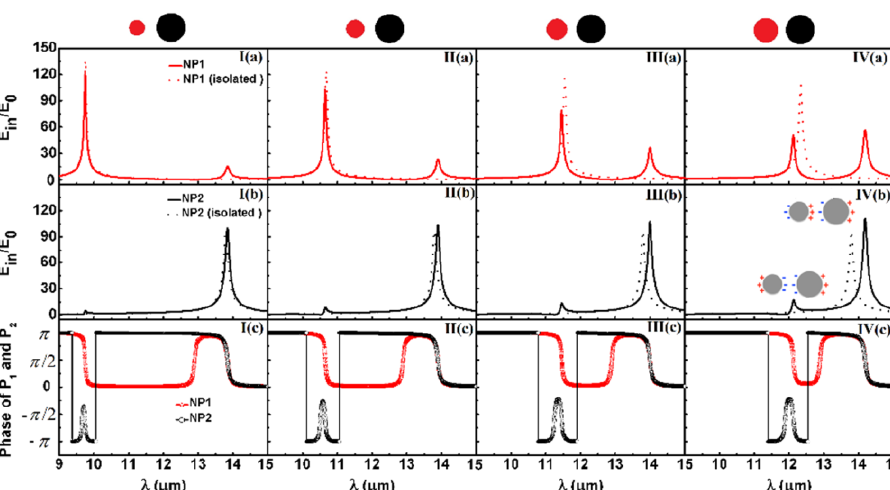
Figure 2. Internal field enhancement spectra for graphene-wrapped dielectric dimers with constant center-to-center distance of d = 210 nm, for small particle (NP1, upper panels) and the large particle (NP2, middle panels) with various radii of small particle ( I ) r 1 = 50 nm, ( II ) r 1 = 60 nm, ( III ) r 1 = 70 nm, and ( IV ) r 1 = 80 nm, and with a fixed radius of large particle r 2 = 100 nm. The dashed line in each panel shows the analytical single particle field enhancement. Down panels illustrate the phase of each dipole moments in dimer calculated by Equation (6). The host medium is chosen as vacuum, ε = 2.25, E F = 0.3 eV, and τ = 1